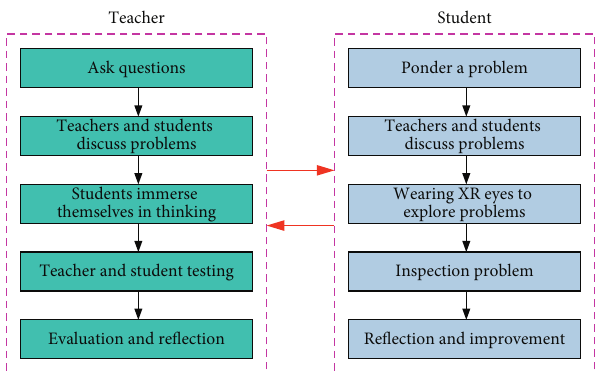
Figure 2: Interactive behavior between teachers and students in immersive